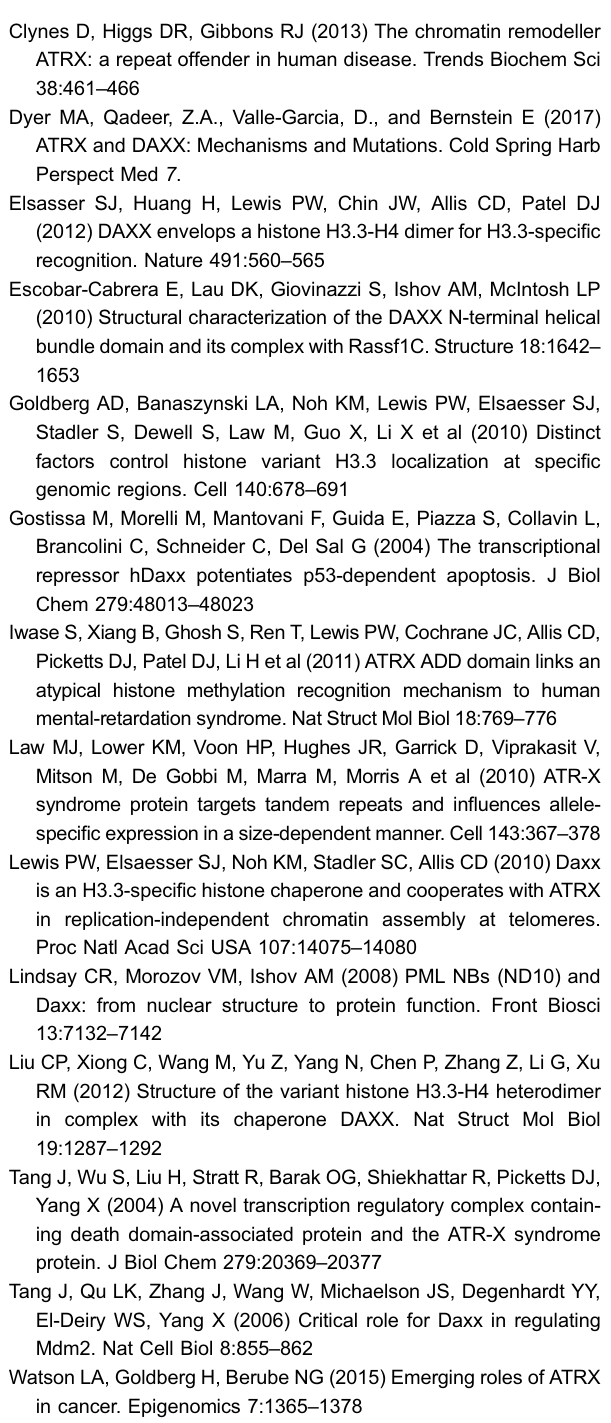
Figure 2. The interfaces between DAXX DHB and ATRX DBM . (A) Details of hydrophobic contacts in the DAXX DHB -ATRX DBM interface. The contacting residues are presented as ball-and- stick models. DAXX residues are colored in green and ATRX residues are colored in cyan. (B and C) Effects of mutations in the ATRX 1,253 – 1,326 (B) and DAXX 55 – 144 (C) on the interaction between DAXX and ATRX analyzed by ITC assays. The K d values for WT and mutants were indicated. “ N.D. ” stands for “ Not Detectable ” . (D) Details of salt bridge and hydrogen- bonding interactions between DAXX DHB and ATRX DBM , shown as dashed red lines. (E) The N- and C-terminal extensions of ATRX DBM may interact with DAXX DHB . DAXX DHB is shown in surface representation and colored according to its electrostatic potential (positive potential, blue; negative potential, red). The absent N- and C-terminal extensions cannot be modeled unambiguously. The red dashed lines indicate possible location of these missing extensions for illustration purpose. (F) Effects of truncations and mutations of ATRX DBM on DAXX-ATRX interactions shown by ITC assays. (G) Superimposition of DAXX DHB -ATRX DBM and DAXX DHB -RASSF1C DBM (PDB: 2KZU) structures shown in two orthogonal views. DAXX DHB in DAXX DHB -ATRX DBM complex, green; ATRX DBM , cyan; DAXX DHB in DAXX DHB -RASSF1C DBM complex, yellow; RASSF1C DBM , red. (H) The conserved hydrophobic interfaces in two structures. The structural equivalent residues are indicated. (I) The sequence alignment of ATRX DBM and RASSF1C DBM shows low similarity. The structural equivalent residues are not sequentially